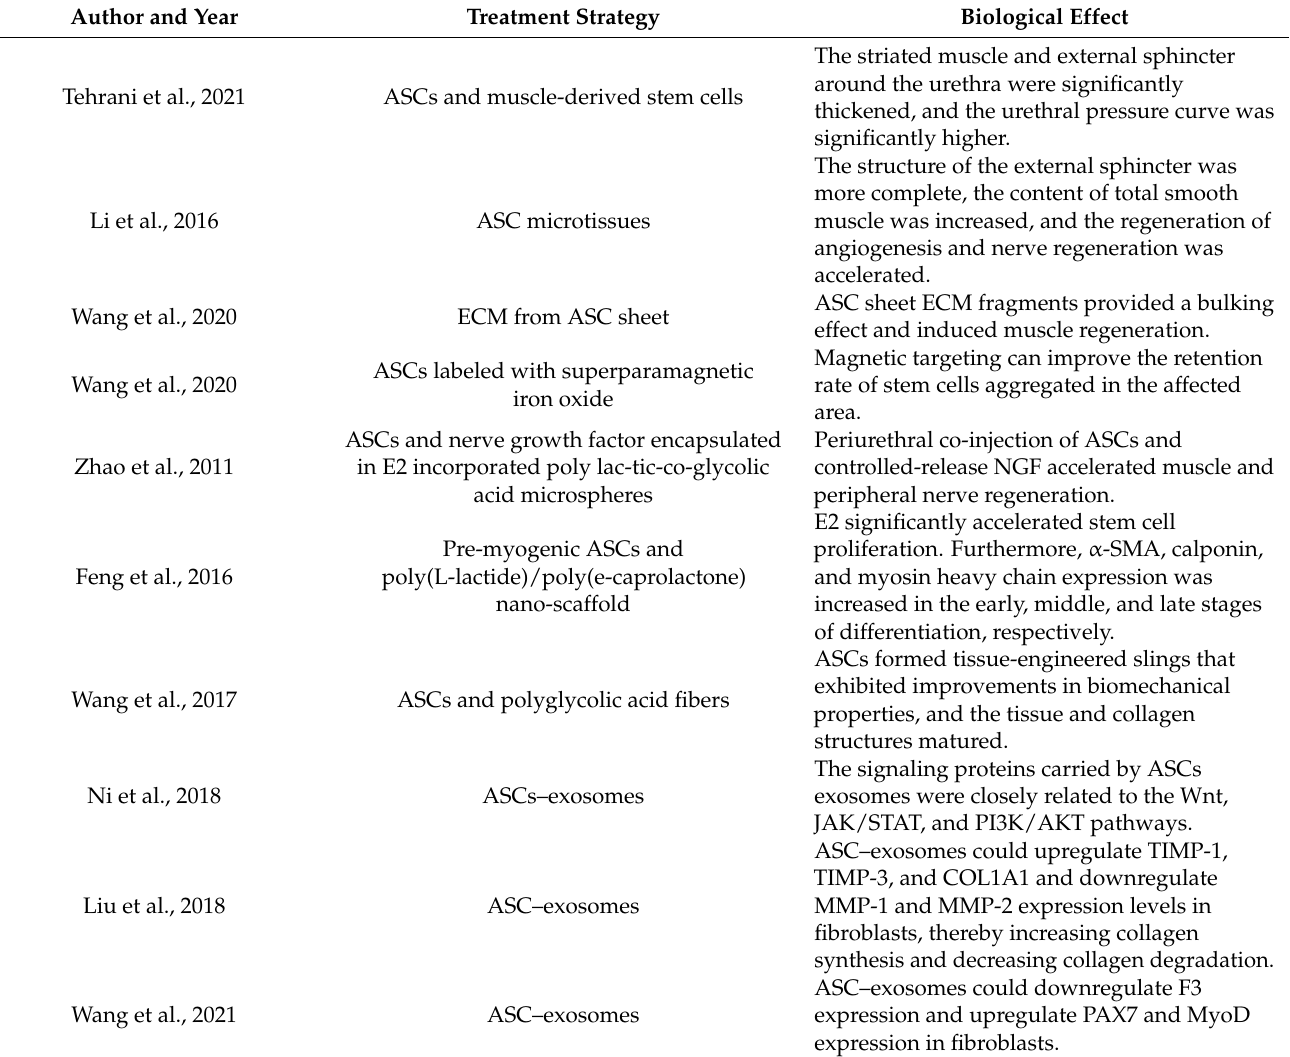
Table 3. Overview of ASC-based therapy for stress urinary